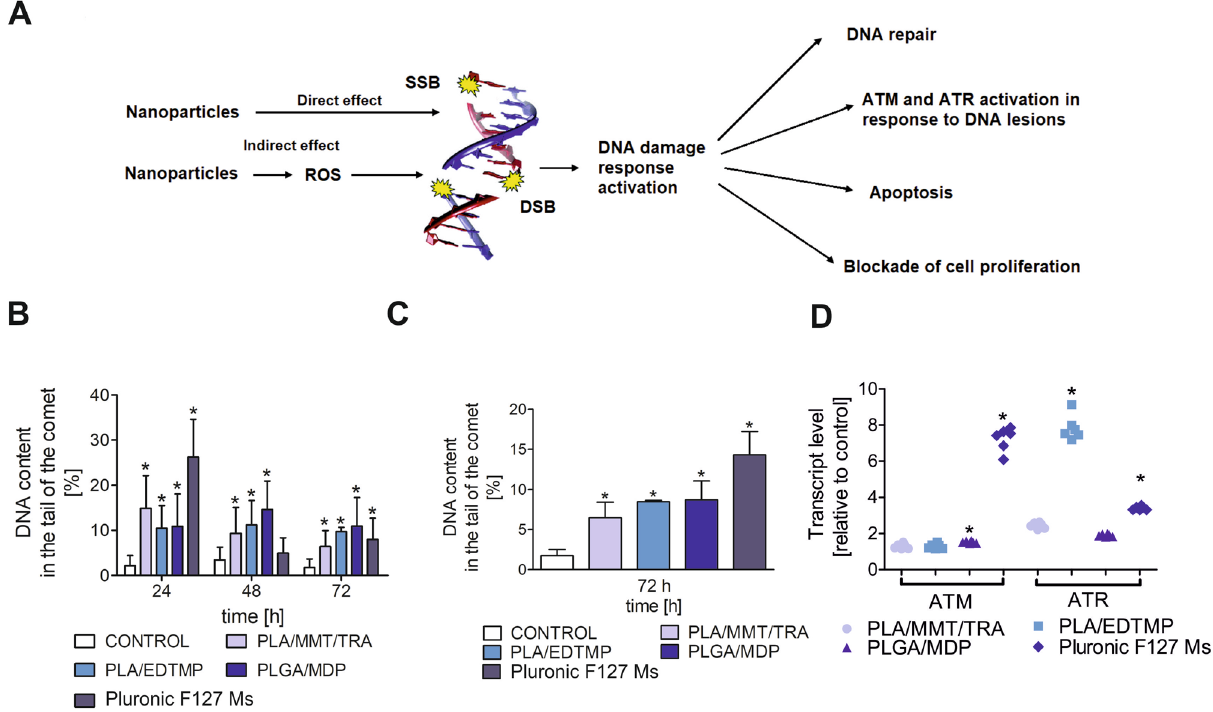
Figure 3. Genotoxic NP activity in human endothelial cells ( A ) Schematic overview of DNA damage and its consequences. ( B , C ) NP genotoxicity in HUVEC-STs. Cells were treated with PLA/MMT/TRA, PLA/EDTMP, PLGA/MDP (100 μg/mL), or Pluronic F127 Ms (0.25 μg/mL) ( B ) for up to 72 h or incubated only for 72 h with double doses of NPs: PLA/MMT/TRA, PLA/EDTMP, PLGA/MDP (200 μg/mL), or Pluronic F127 Ms (0.5 μg/mL) ( C ). DNA damage was evaluated by measuring DNA percentage in comet tail by alkaline version of comet assay (pH > 13). *p < 0.05, significant differences between NP-treated and control cells. Fifty images were analysed from each slide. Data are the means ± SD of three independent experiments. ( D ): ATM and ATR gene transcript expression (relative to HPRT1 housekeeping gene) in HUVEC-STs exposed to NPs for 24 h. Bars represent the means ± SD of three separate experiments (n 6). Asterisks refer to level of significant (*p < 0.05, n = 6) difference in cell transcription treated with investigated NPs compared to untreated